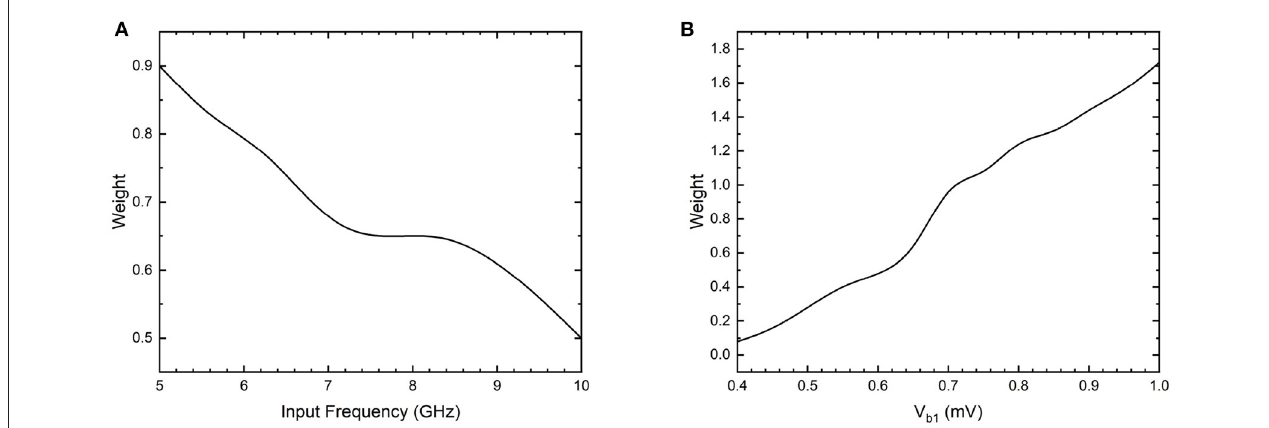
FIGURE 14 | Simulation results of weight between an input-output node 1 in the 3 × 3 coupled synapse network shown in Figure 12 , with an additional 100 k (cid:127) resistor included parallel with C 1 . (A) Weight as a function of input frequency of V 1 with constant bias voltages. (B) Weight as a function of bias voltage V b1 with input pulse voltage excitations of constant amplitude and